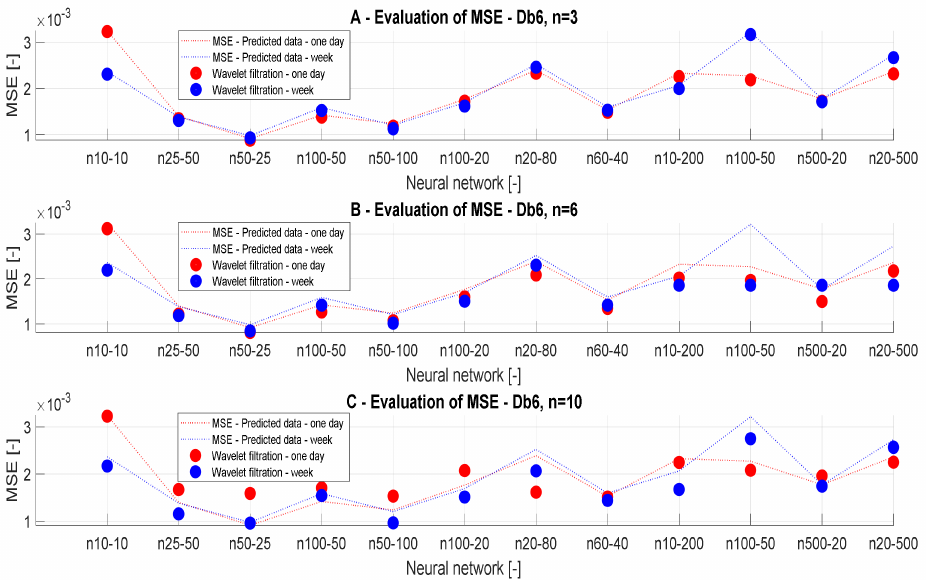
Figure 10. MSE values, a comparison of the reference signal with di ff erent wavelet